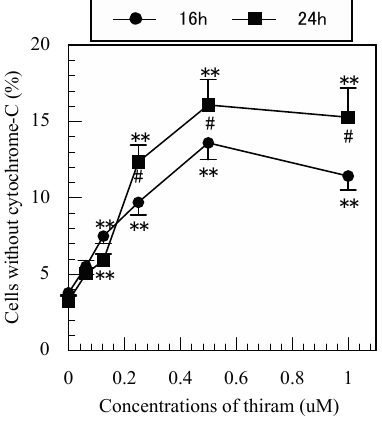
Figure 7. Detection of mitochondrial cytochrome-c release in apoptotic cells by flow cytometry. Data are presented as the mean ±SD (n = 3). **: p < 0.01, significantly different from 0 µM, #: p < 0.05, significantly different between 16 and 24 h by Tukey’s test. Table 1. Analytical results of the two-way repeated measures ANOVA.